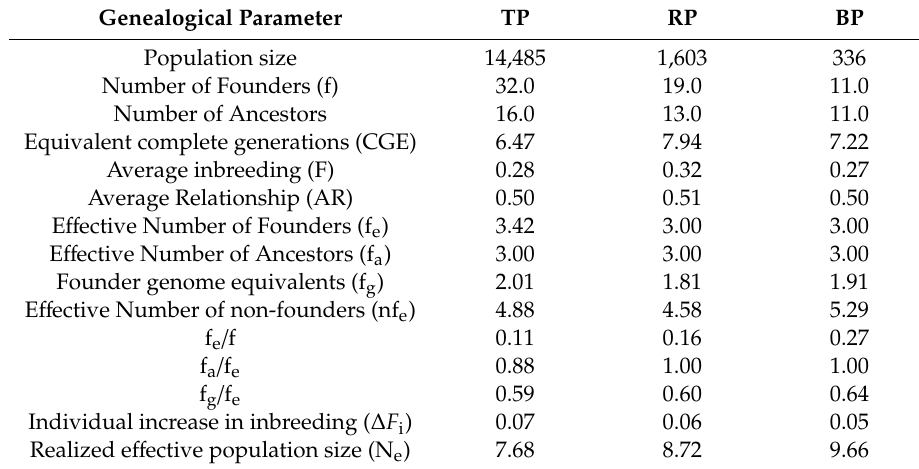
Table 3. Main genealogical parameters for the Nero di Parma breed in the total, reference, and breeding populations (TP, RP, and BP, respectively).